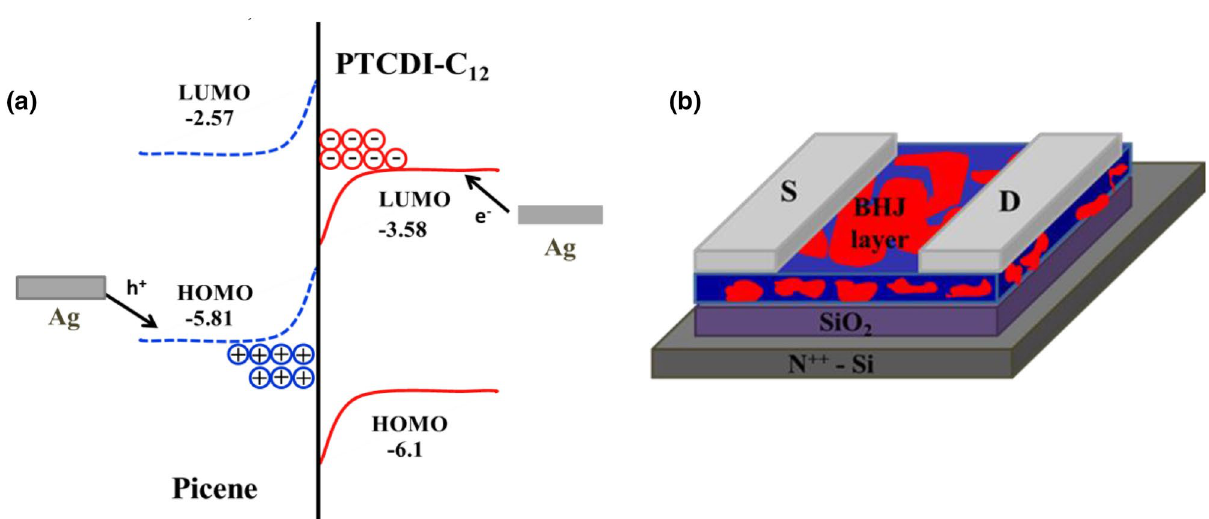
Figure 8. ( a ) Energy level diagram for picene—C12-PTCDI system ( b ) schematic illustration of the BHJ OFET device. Figures were drawn in Microsoft Office PowerPoint (https ://www.micro soft.com/en-in/micro soft-365/ power point